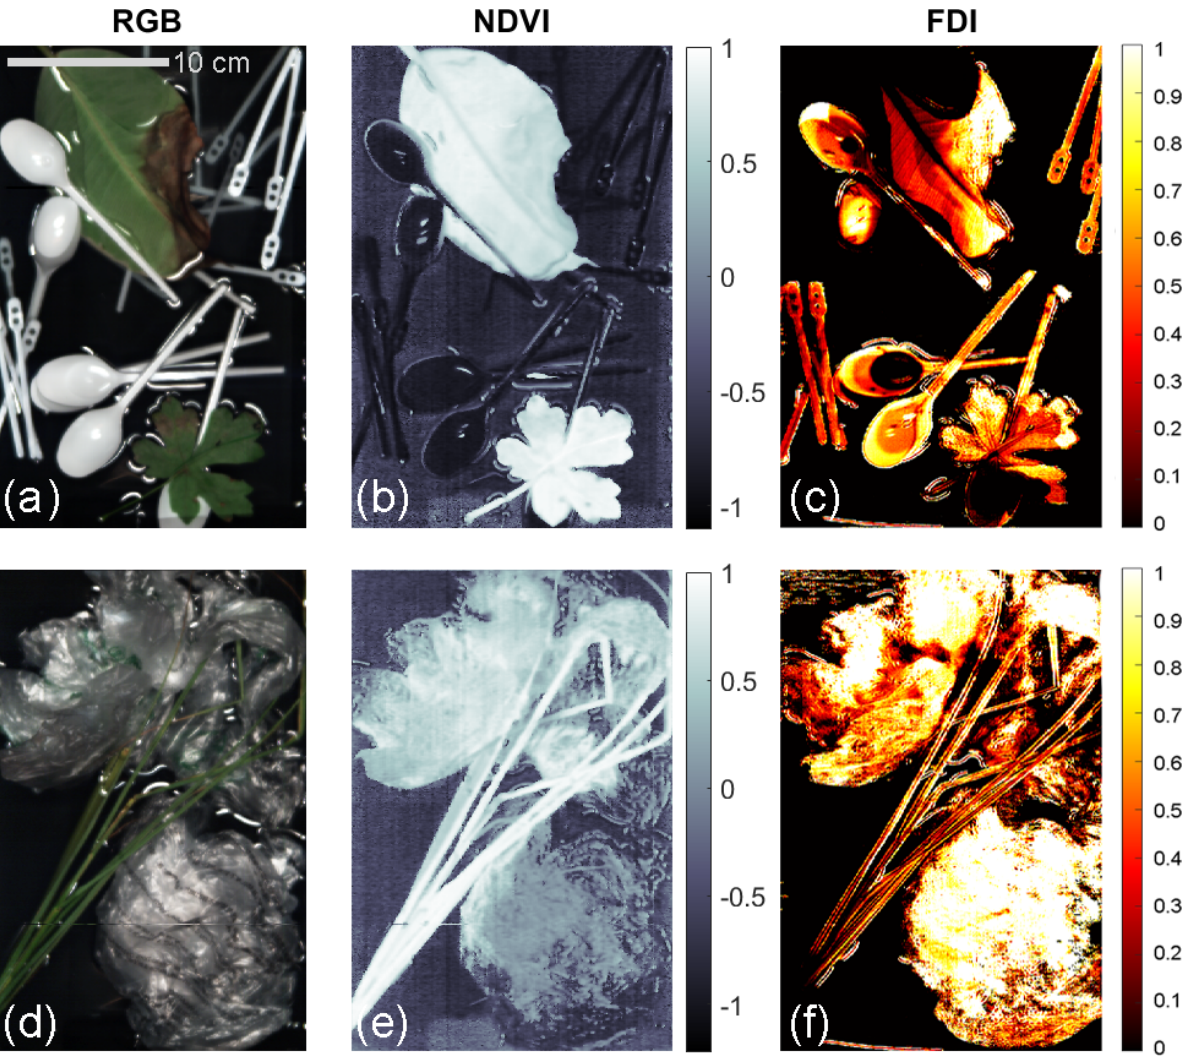
Figure 7. Two examples of the Normalised Difference Vegetation Index (NDVI) ( b , e ), and Floating Debris Index (FDI) ( c , f ) with their respective RGB images ( a , d ) of vegetation, PP spoons ( a – c ), PS coffee stirrers ( a – c ), and clear LDPE bags ( d – f ).